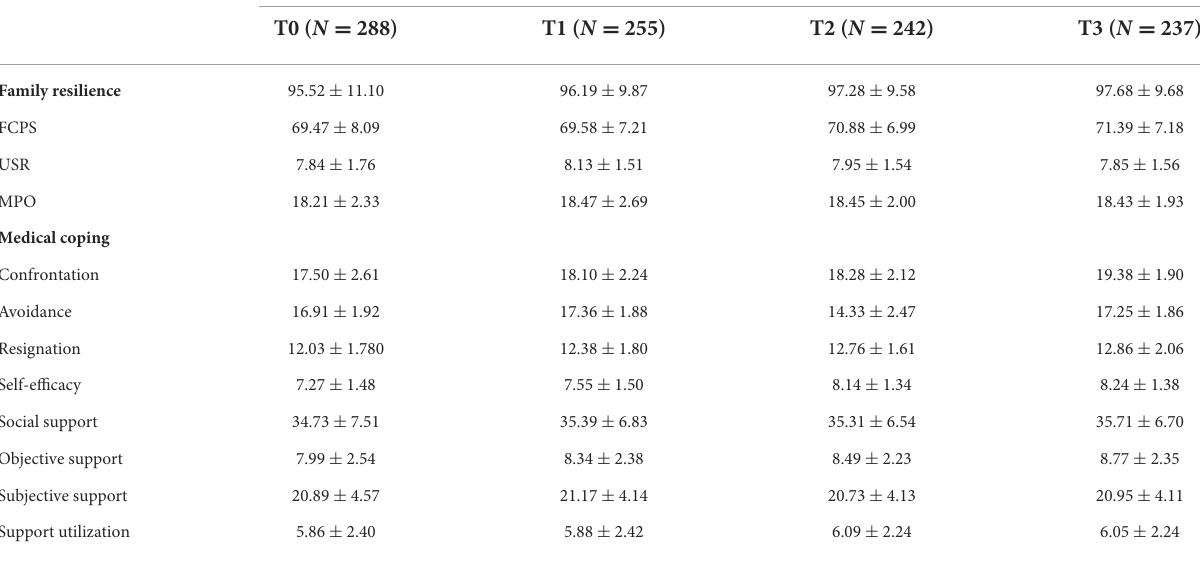
Baseline predictors of family resilience at 6 months Univariate analyses demonstrated that the baseline variables associated with FRAS-C at T3 were living region ( Z =